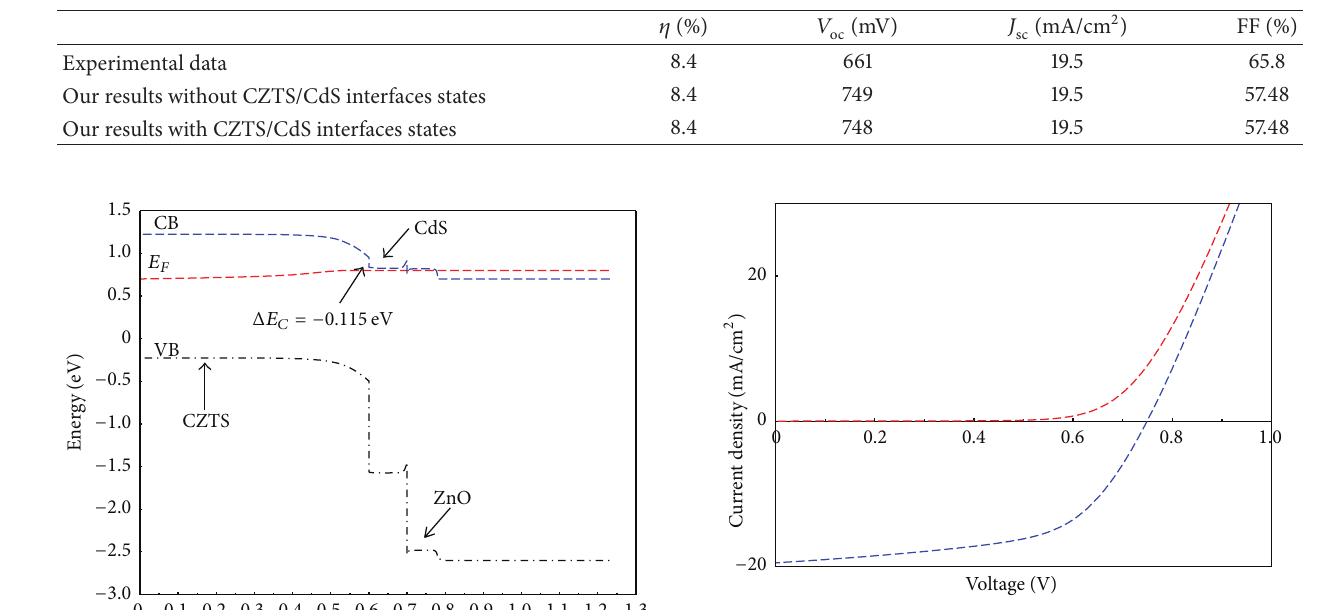
Table 2: Simulated results compared to experimental data of [9].